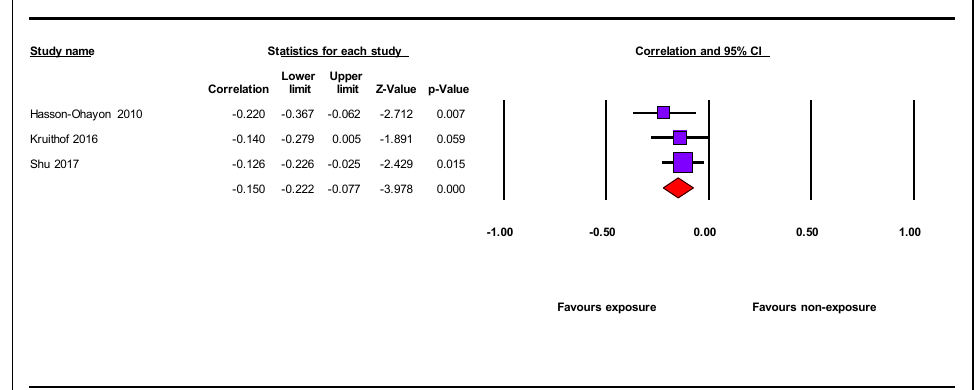
Figure 4. Forest plot of the association of received social support and caregiver anxiety symptoms [51,53,68].